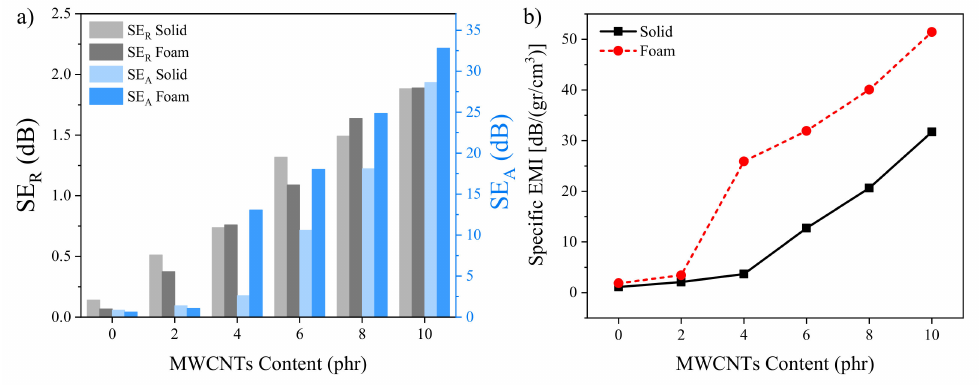
Figure 6. ( a ) SE A and SE R and ( b ) specific electromagnetic interference (EMI) shielding e ffi ciency (SE) of the samples at 10